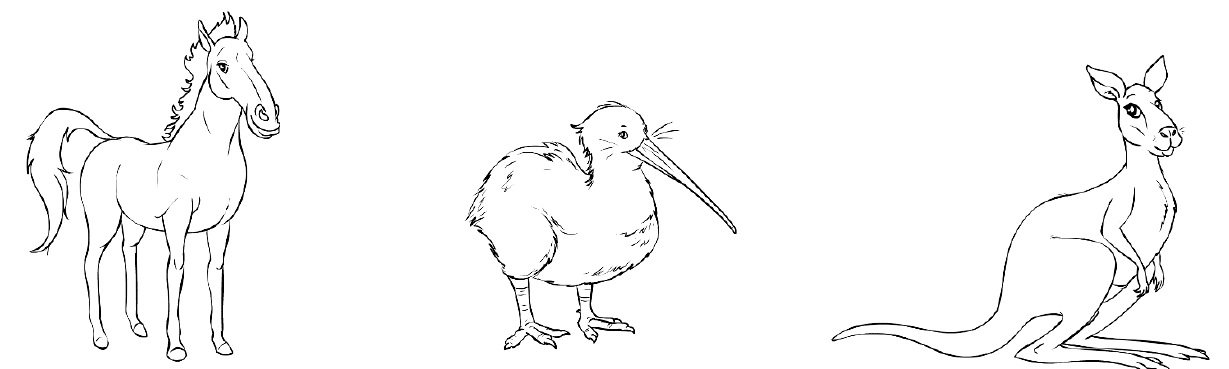
Figure 3. Commissioned artwork of prime-types (horse, kiwi, and kangaroo).